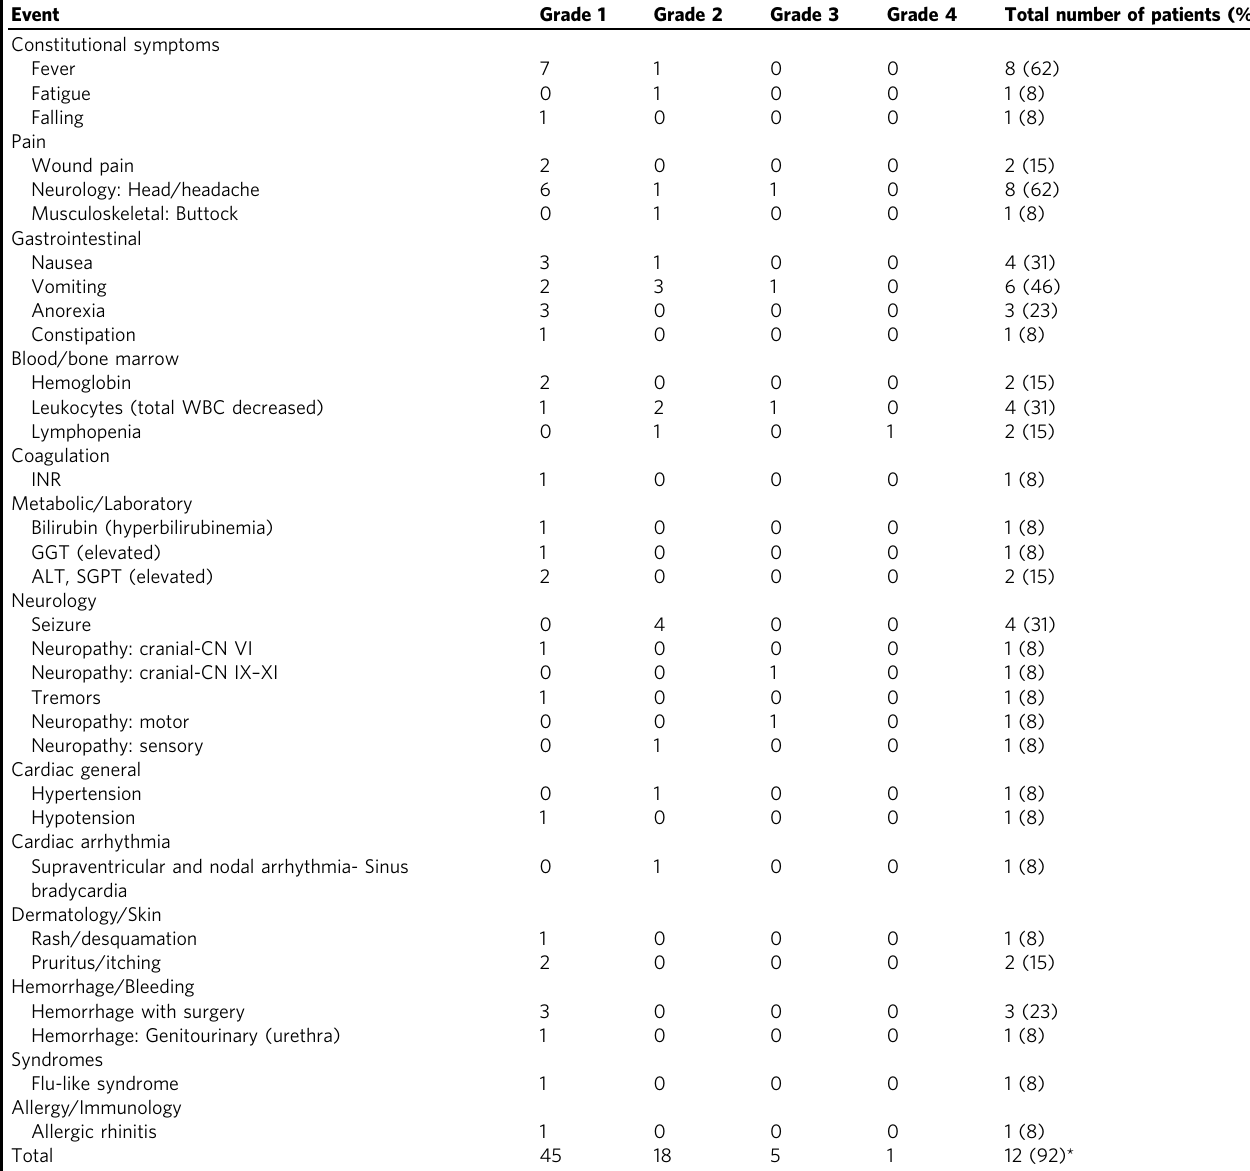
Table 2 Summary of adverse events occurring up to 90 days after G47 Δ ( N =